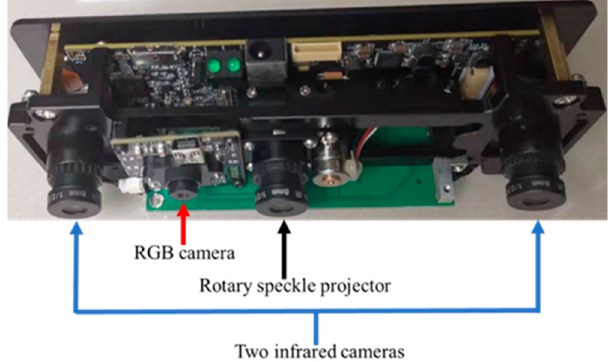
Figure 4. Device of speckle stereo image pairs acquisition.